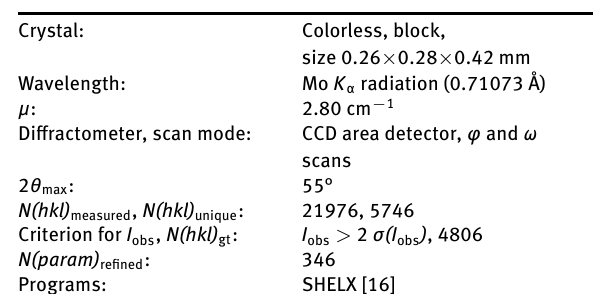
Table 1: Data collection and handling.